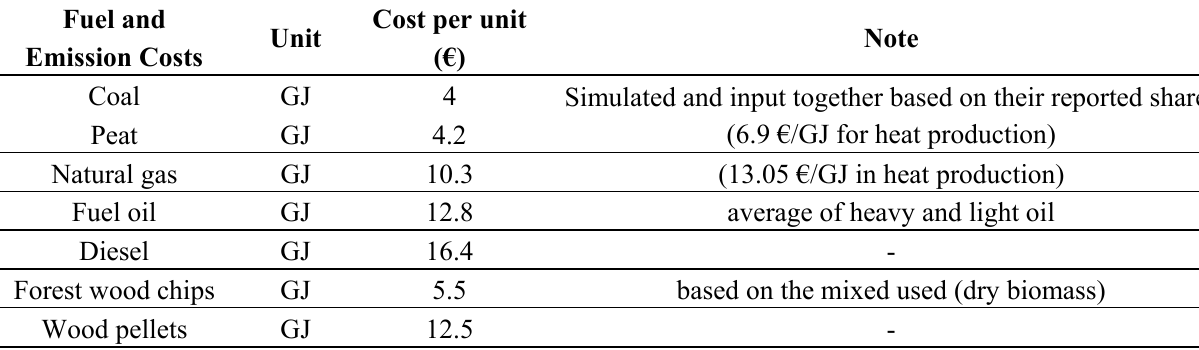
Table B2. Fuel costs (excluding taxes) for the reference scenario based on [63,82]. Fuel